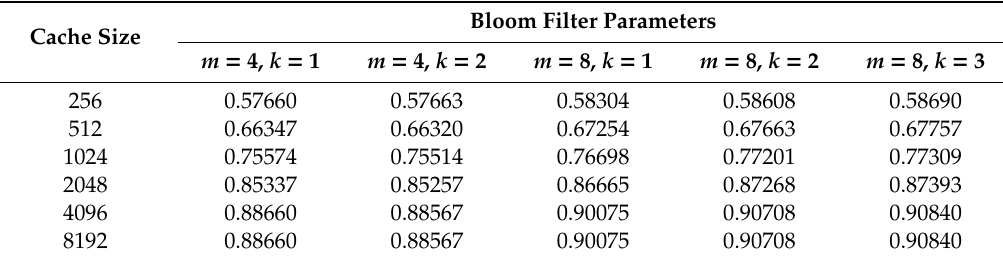
Table 4. Cache hit ratio with Bloom filters having size m and the number of hash functions k .